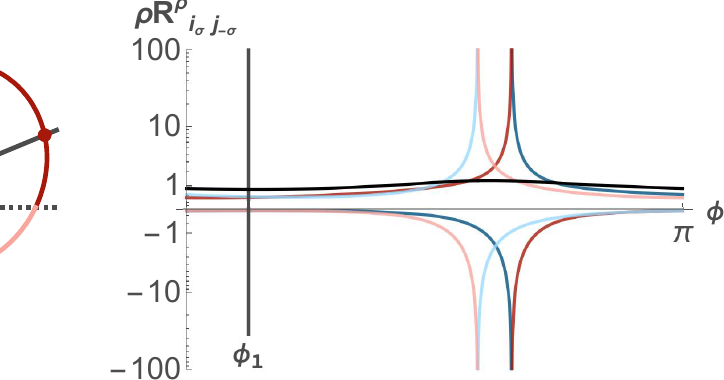
rameterised by r + (light), respectively.